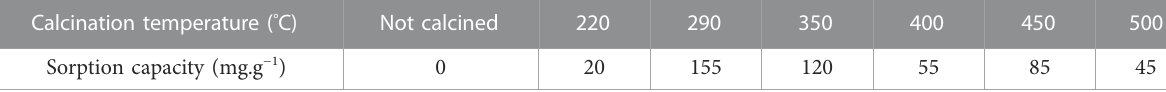
TABLE 2 Iodine sorption capacity of lead-vanadate sorbents. Calcination temperature ( °